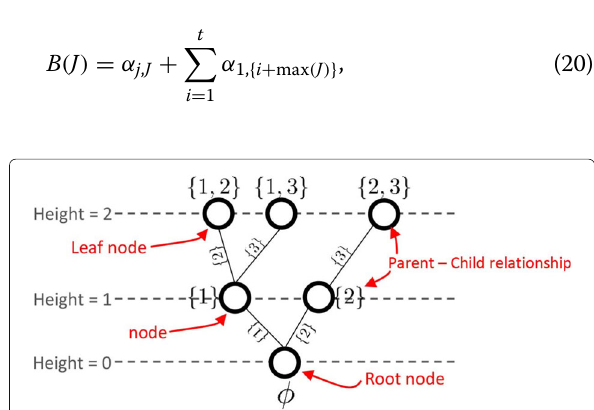
Fig. 1 A tree structure following the legitimate order for k = 2